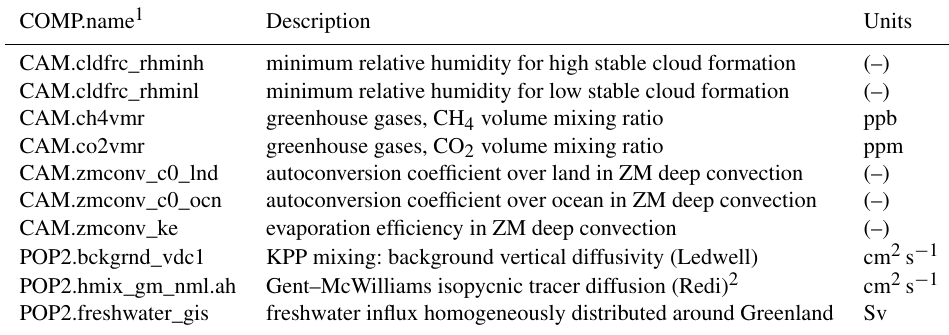
Table 3. CESM definition of control variables.